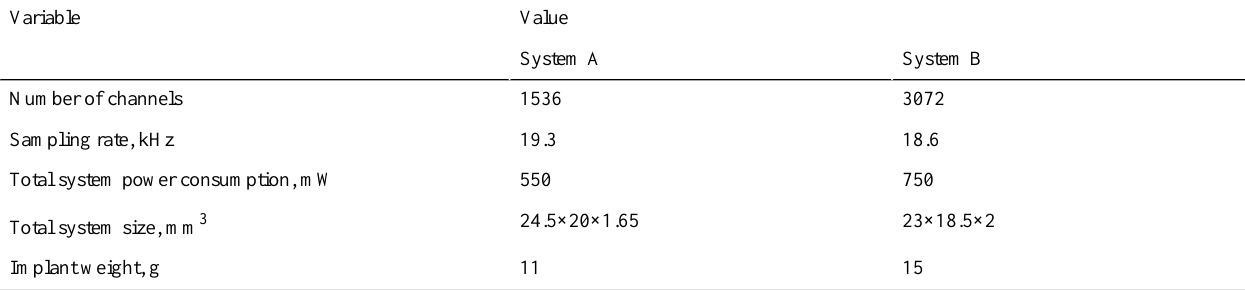
Table 2. Two recording system